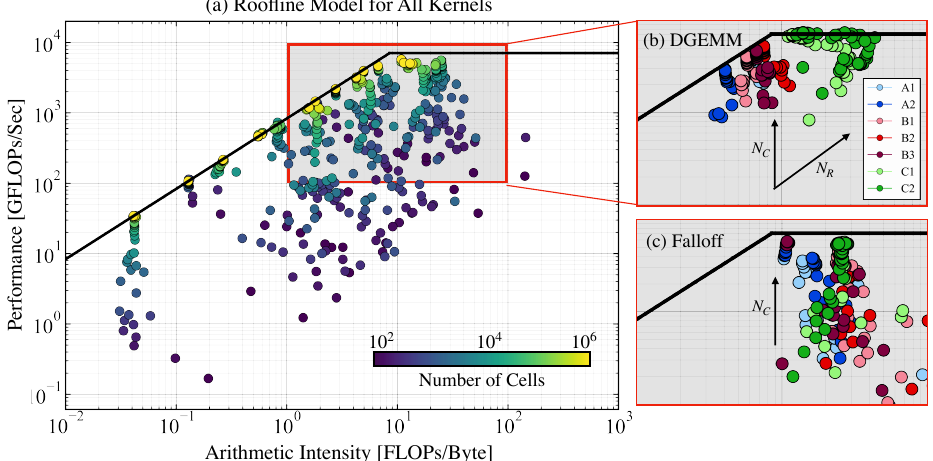
Figure 5. ( a ) Roofline model for mechanism B3 for all kernels encountered during the source term computation. Each marker represents a unique kernel evaluated for the number of cells N C indicated by its color. ( b ) Roofline model for the DGEMM kernel. ( c ) Roofline model for the Troe falloff kernel. In ( b , c ), the different colors represent different mechanisms (see Table 1) and the distribution of points of the same color comes from the various N C